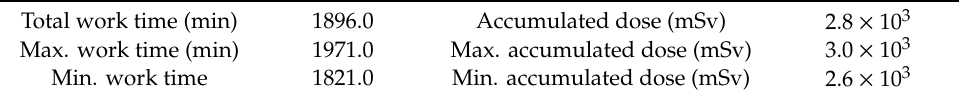
Table 5. Work time and estimated dose for the fragmentation of the active part.